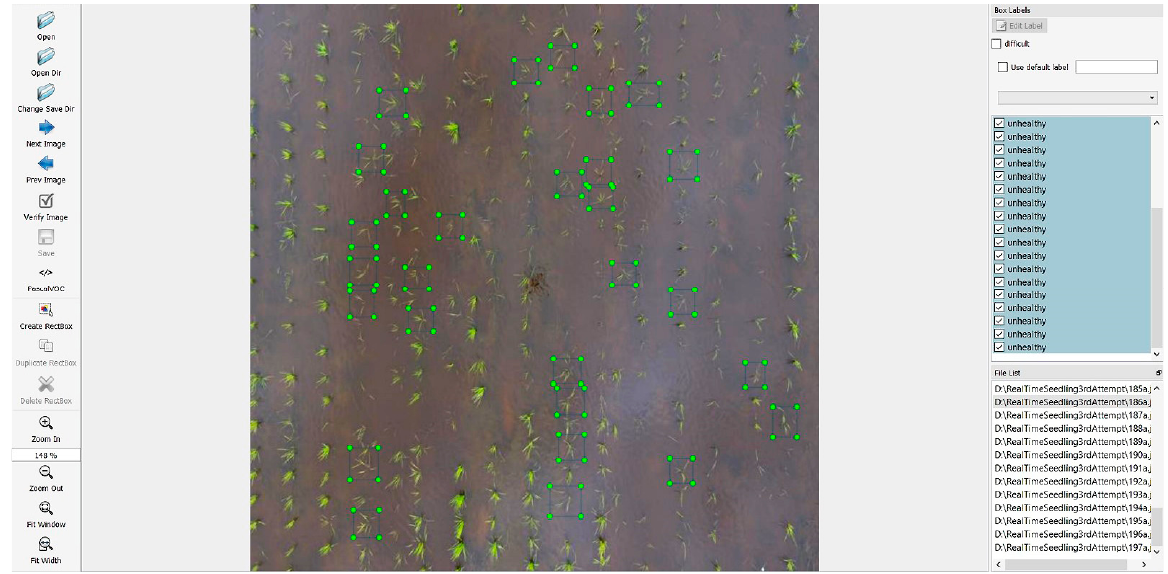
Table 1. Number of images and bounding boxes in the training and testing datasets.